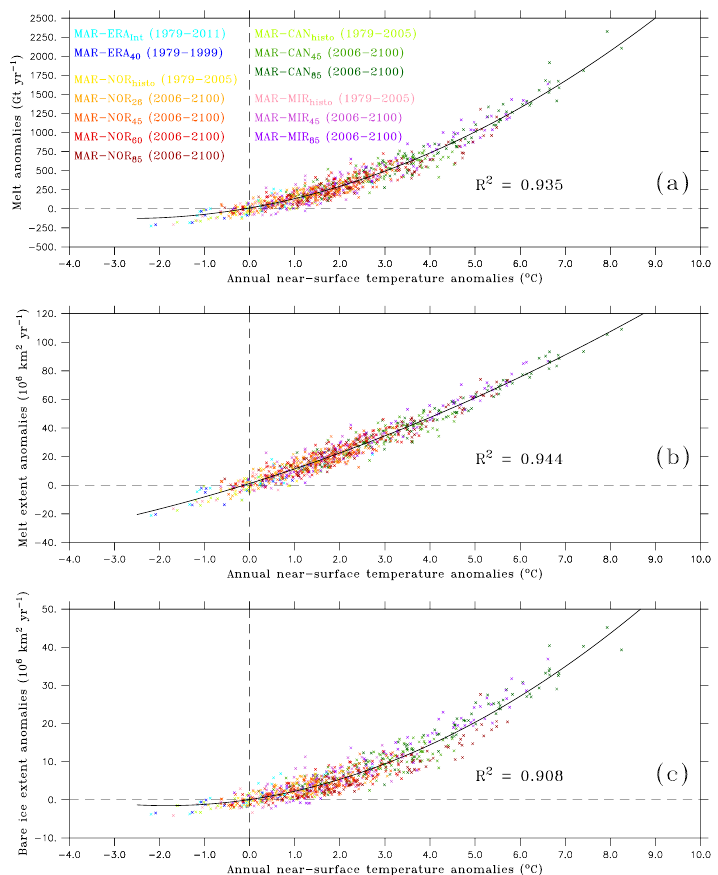
Fig. 4. (a) Annual melt anomalies (Gtyr − 1 ) from the GrIS according to the annual near-surface air temperature anomalies ( ◦ C), for the different MAR simulations forced by the reanalyses and the CMIP5 GCMs, with regression drawn in a solid black line. All the annual anomalies are related to the 1980–1999 average outputs provided by MAR forced with the same forcing fields. (b) The same as (a) , but for the annual anomalies of cumulated daily melt extents (10 6 km 2 yr − 1 ) on the GrIS, based on significant melt rates higher than 1mmWEday − 1 . (c) The same as (b) , but for the annual anomalies of cumulated daily bare ice extents (10 6 km 2 yr − 1 ) on the GrIS.